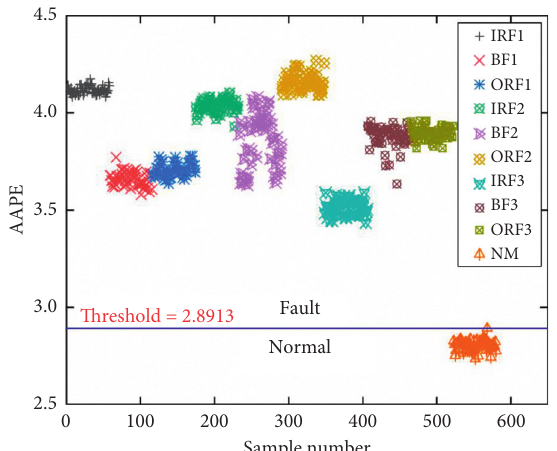
Figure 10: The amplitude-aware permutation entropy distribution of all